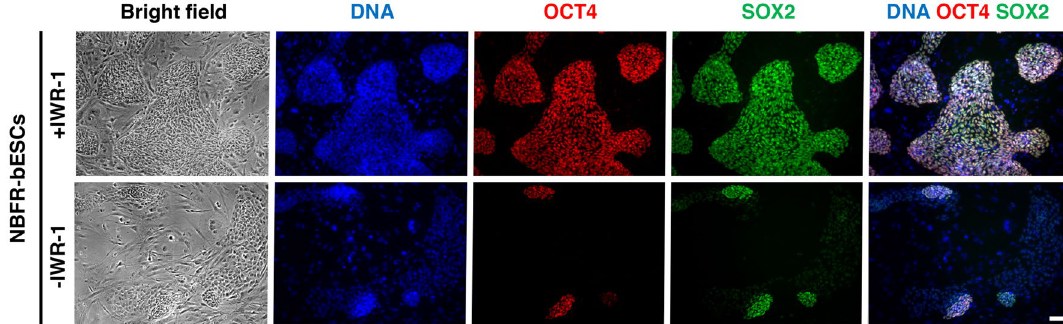
Figure 5. IWR-1 supplementation is required for pluripotency of NBFR-bESCs cultured on MEF feeders. Immunostaining of pluripotency factors OCT4 and SOX2 in NBFR-bESCs grown on MEF feeders for 5 passages after IWR-1 withdrawal. Scale bar 100